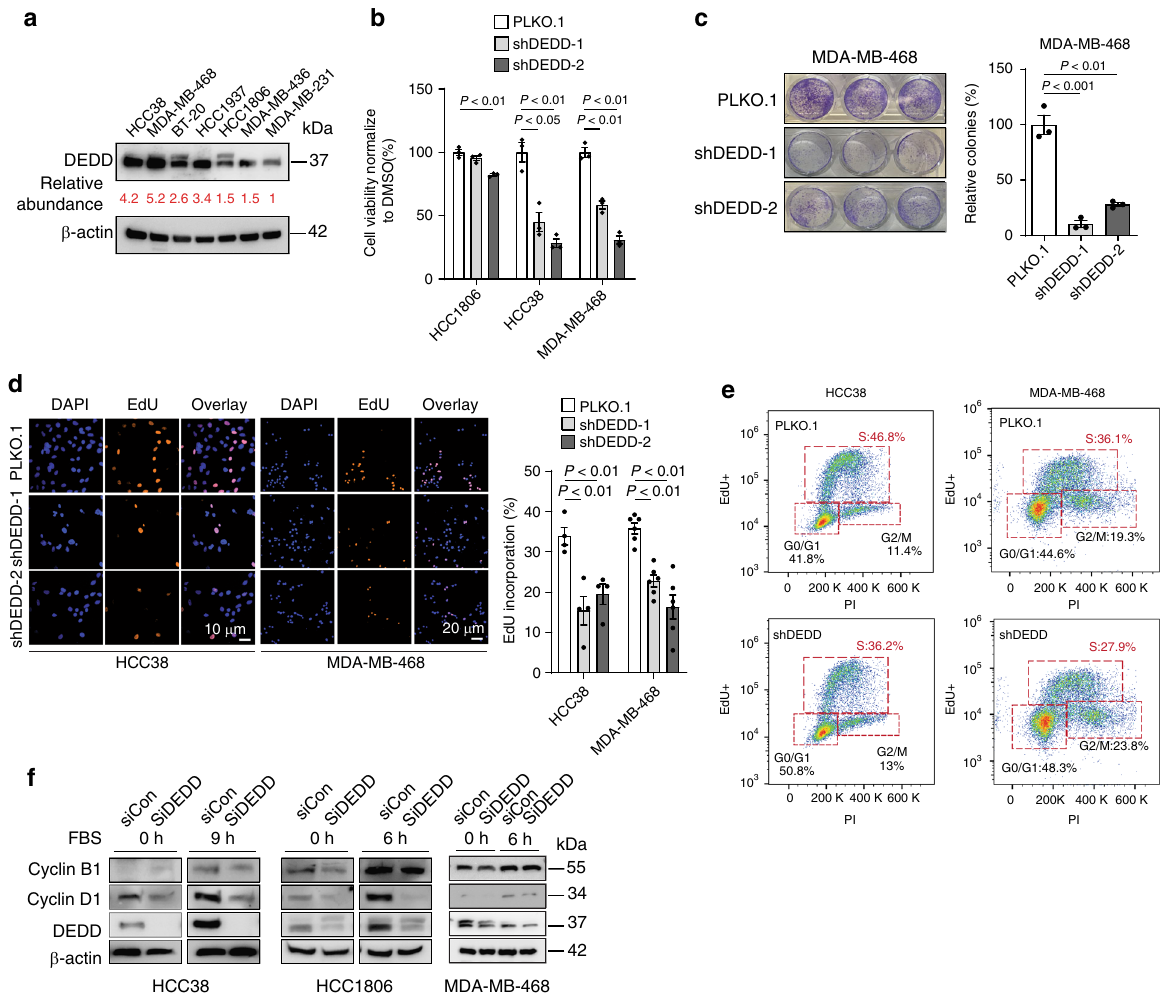
Fig. 2 High death effector domain-containing DNA-binding protein ( DEDD ) expression facilitates G1/S progression in triple-negative breast cancers (TNBCs). a Western blots showing the endogenous DEDD expression across multiple TNBC cell lines. b Cell counting assay showing cell relative cell viability after DEDD knockdown in three TNBC cell lines. c Clonogenic assay showing relative colony number changes after DEDD knockdown in MDA-MB- 468 cells. d , Left: Representative images showing 5-ethynyl-2 ′ -deoxyuridine (EdU) incorporation in TNBC cells with or without short hairpin DEDD (sh DEDD ) expression. 4 ′ ,6-Diamidino-2-phenylindole (DAPI) staining (blue); EdU staining (orange). Right: Quanti fi cation of EdU incorporation. e Representative fl ow biaxial plots showing cell cycle population distribution in TNBC cells with or without sh DEDD expression. f Immunoblots showing cyclin B1 and cyclin D1 expression changes with or without small interfering DEDD (si DEDD ) knockdown at 0 and 9/6 h after abolishing synchronization by fetal bovine serum (FBS) in HCC38/HCC1806/MDA-MB-468 cells. All quantitative data were generated from a minimum of three replicates. P values were derived from one-way analysis of variance (ANOVA) with Dunnett ’ s multiple comparison test comparing different shRNAs to the PLKO.1 group. Error bars represent means ±